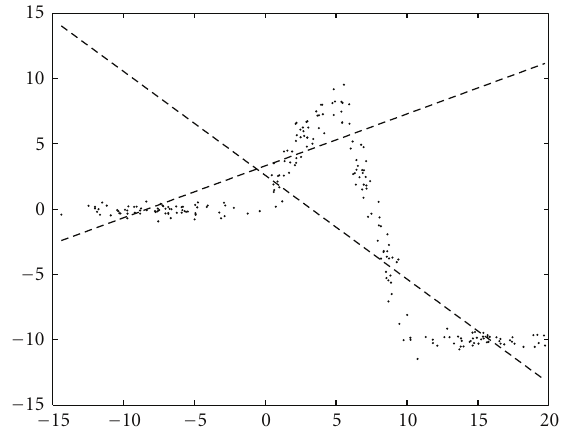
Figure 5: Final hyperplanes (dashed lines) estimated by the hyperplane clustering in the case M = 2.